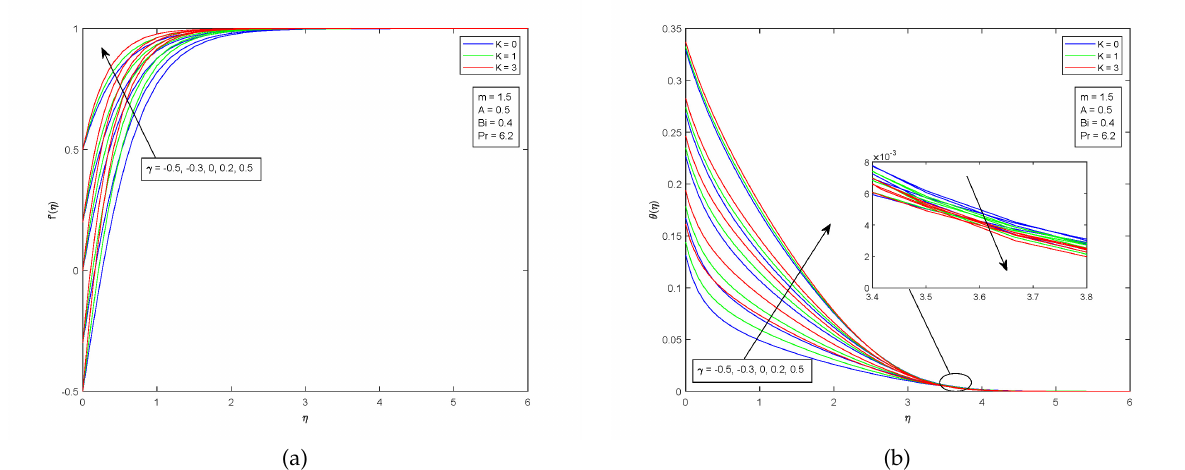
Fig. 3. The effect of γ on velocity and temperature profiles for different values of K